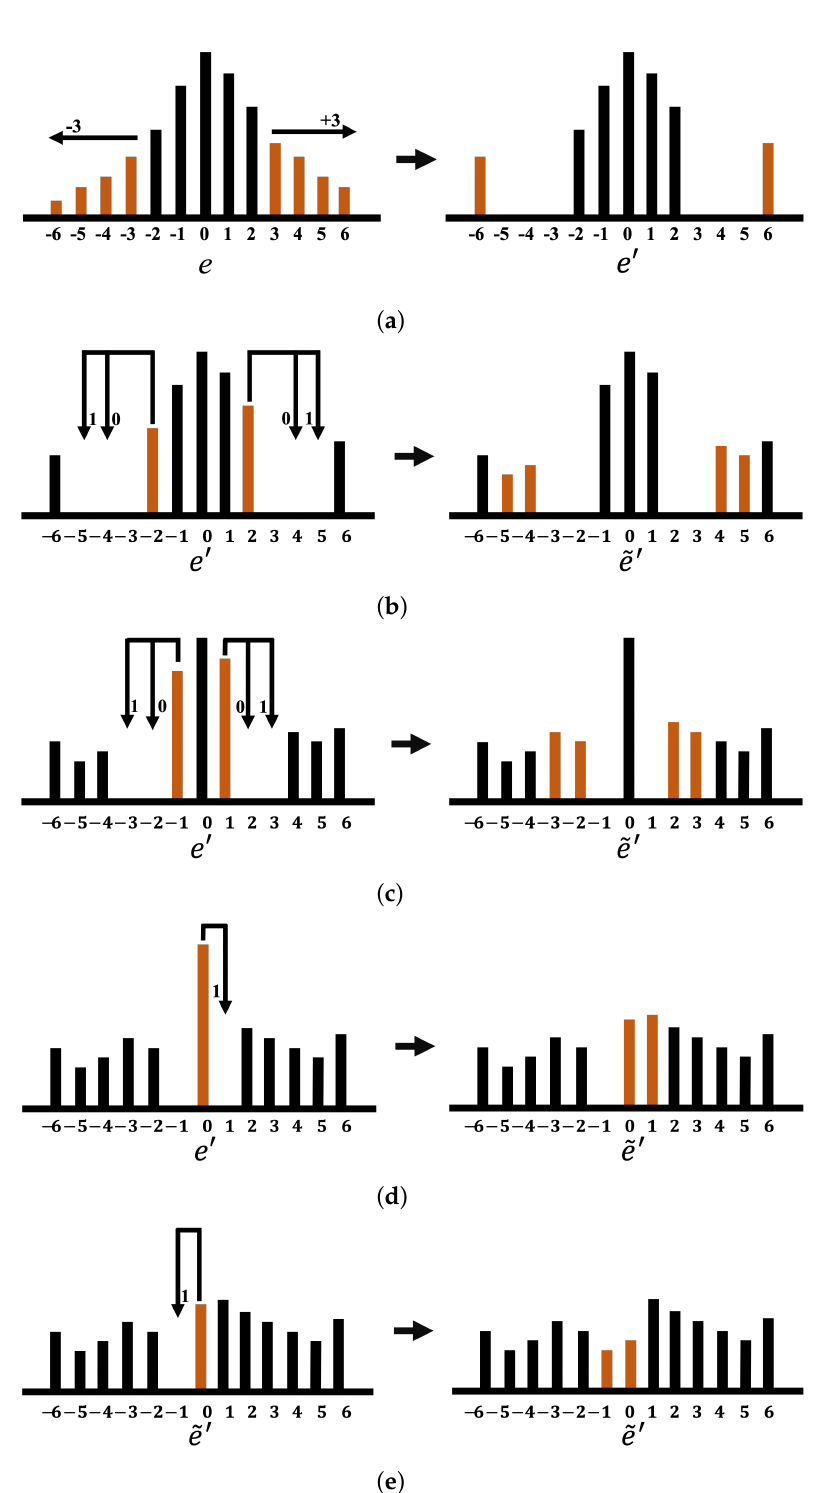
Figure 6. Procedure of data hiding ( L = 2). ( a ) Derivation of empty bins, ( b ) data hiding for pixels | = 2, ( c ) data hiding for pixels with | e (cid:48) | = 1, ( d ) data hiding for pixels with e (cid:48) with | e (cid:48) i , j i , j = hiding for pixels with ˜ e (cid:48) i , j